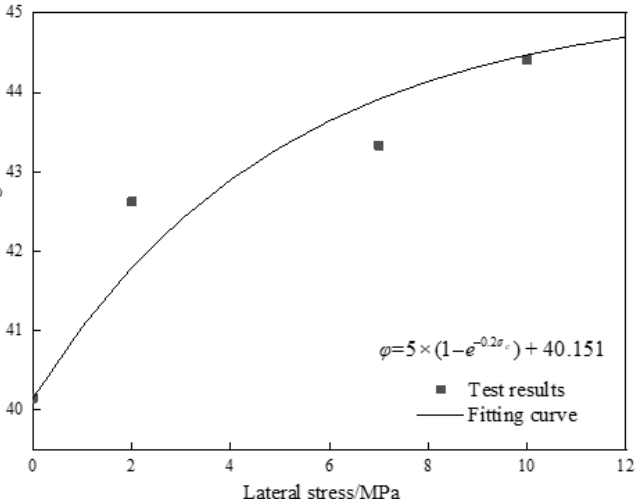
Figure 15. Comparison of the test and fitting results of the relationship between friction angles and lateral stress.